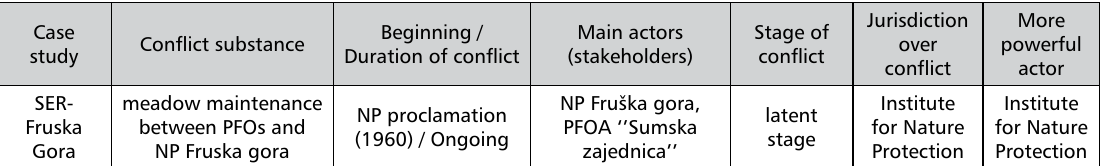
Conflict element